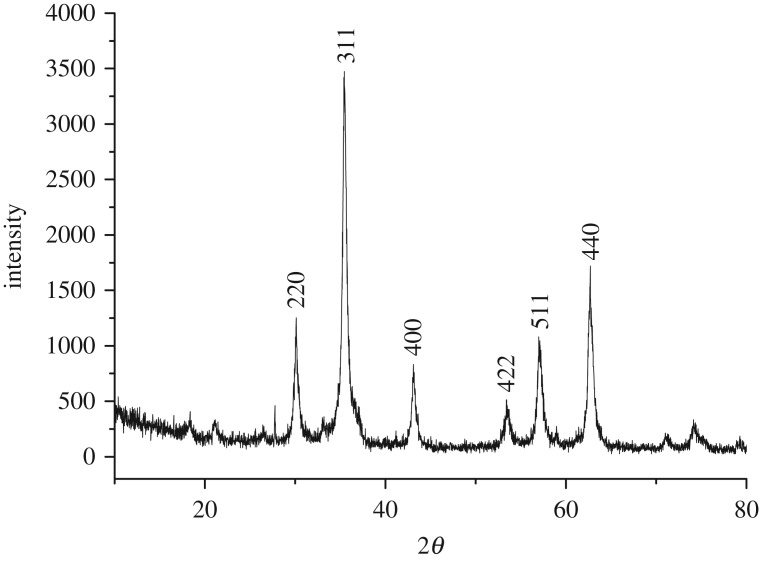
XRD pattern of Fe3O4.